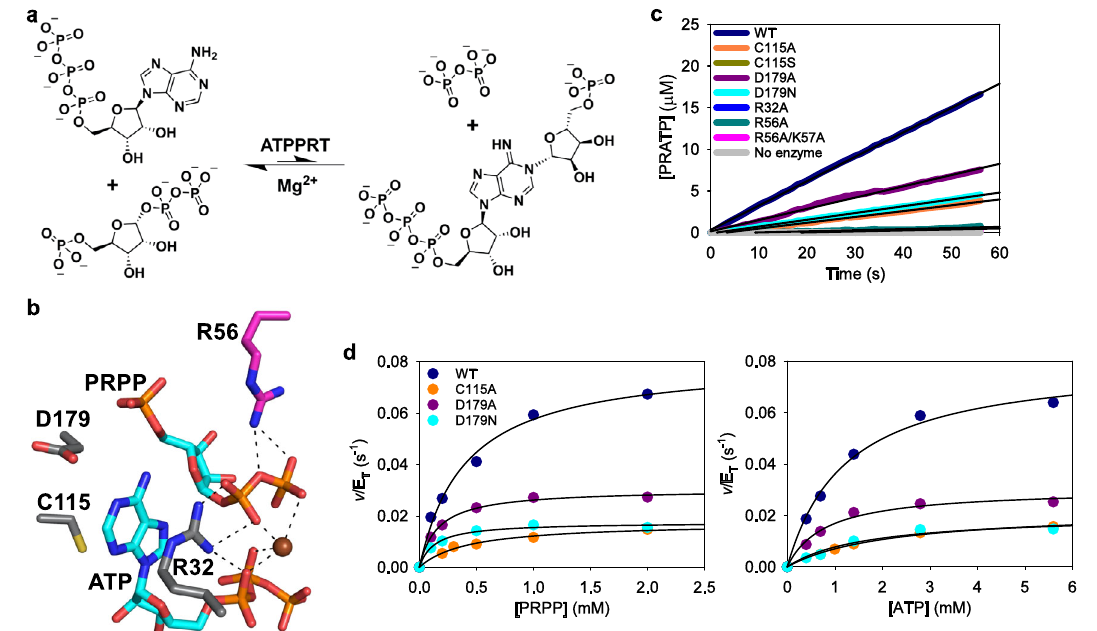
Fig. 1 | The effect of active-site mutations on Pa HisG S . a The reversible, Mg 2+ - formation time course catalysed by 5 μ M Pa HisG S variants. Black lines are linear dependent reaction catalysed by ATPPRT. b Stick model of the active site of regressions of the data.Source data areprovided asa Source Data fi le. d Substrate Pa ATPPRT(PDBID6FU2) 29 .Oxygenisshowninred,nitrogeninblue,phosphorusin saturation curves for WT and mutant Pa HisG S . Data are the mean of two inde- orange,sulphurinyellow,andcarbonineithercyan(substrates),grey(inoneofthe pendent measurements. Lines are best fi t of the data to Eq. (1). Source data are Pa HisG Pa HisG provided as a Source Data fi S subunits)ormagenta(intheother S subunit).Polarinteractionsare depicted asdashed lines, andtheMg 2+ assphere. c Representative traces of PRATP